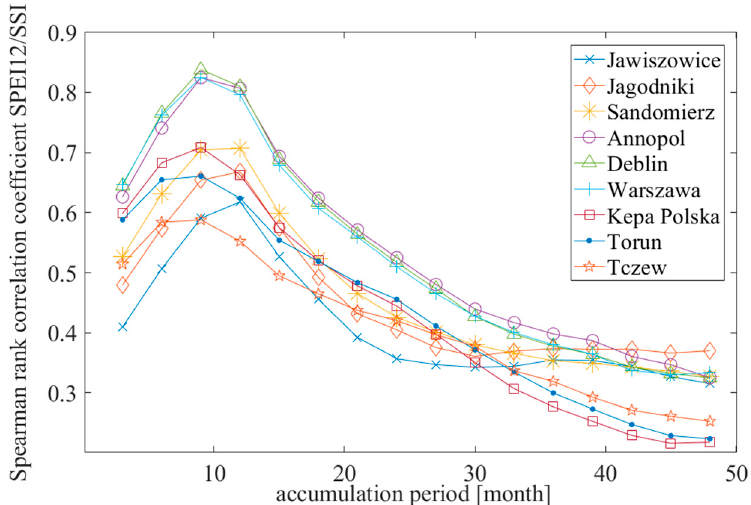
Figure 14. Spearman’s rank correlation coefficients between SPEI12 and SSI as a function of the SSI accumulation time for nine sub-catchments along the Vistula River.